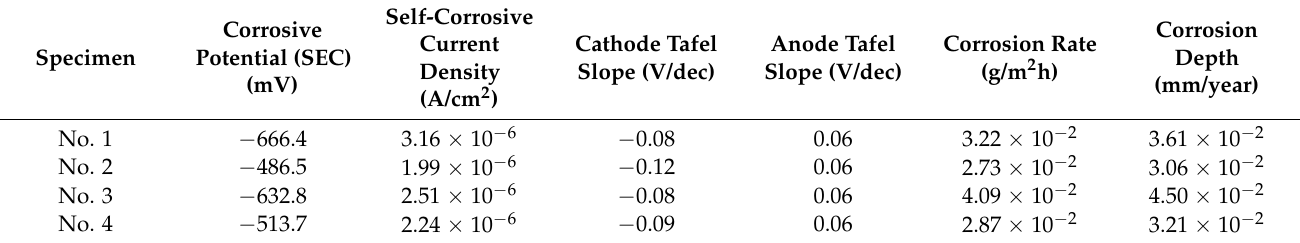
Table 3. Corrosion parameter values of polarization curve.